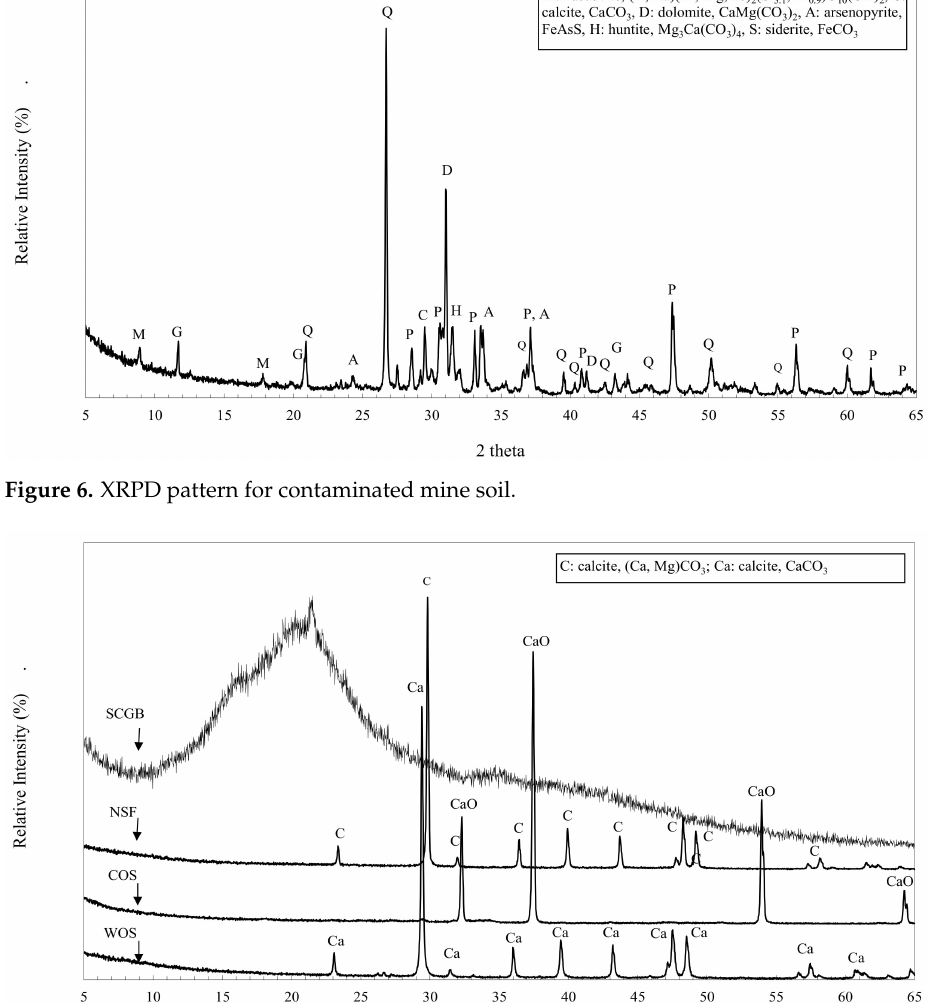
Based on literature, the theoretical decomposition temperature for CaCO 3 is 848 ◦ C when the reaction standard Gibb’s free energy is equal to zero [35]. Moreover, no crystalline phase was identified in the SCGB (Figure